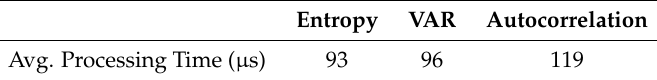
Table 5. Latency of various uncertainty estimation